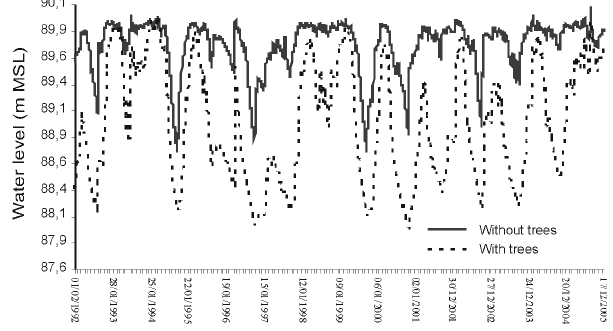
Fig. 6. Impact of coniferous upon the groundwater level dynamics in the Žuvintas raised bog for location A